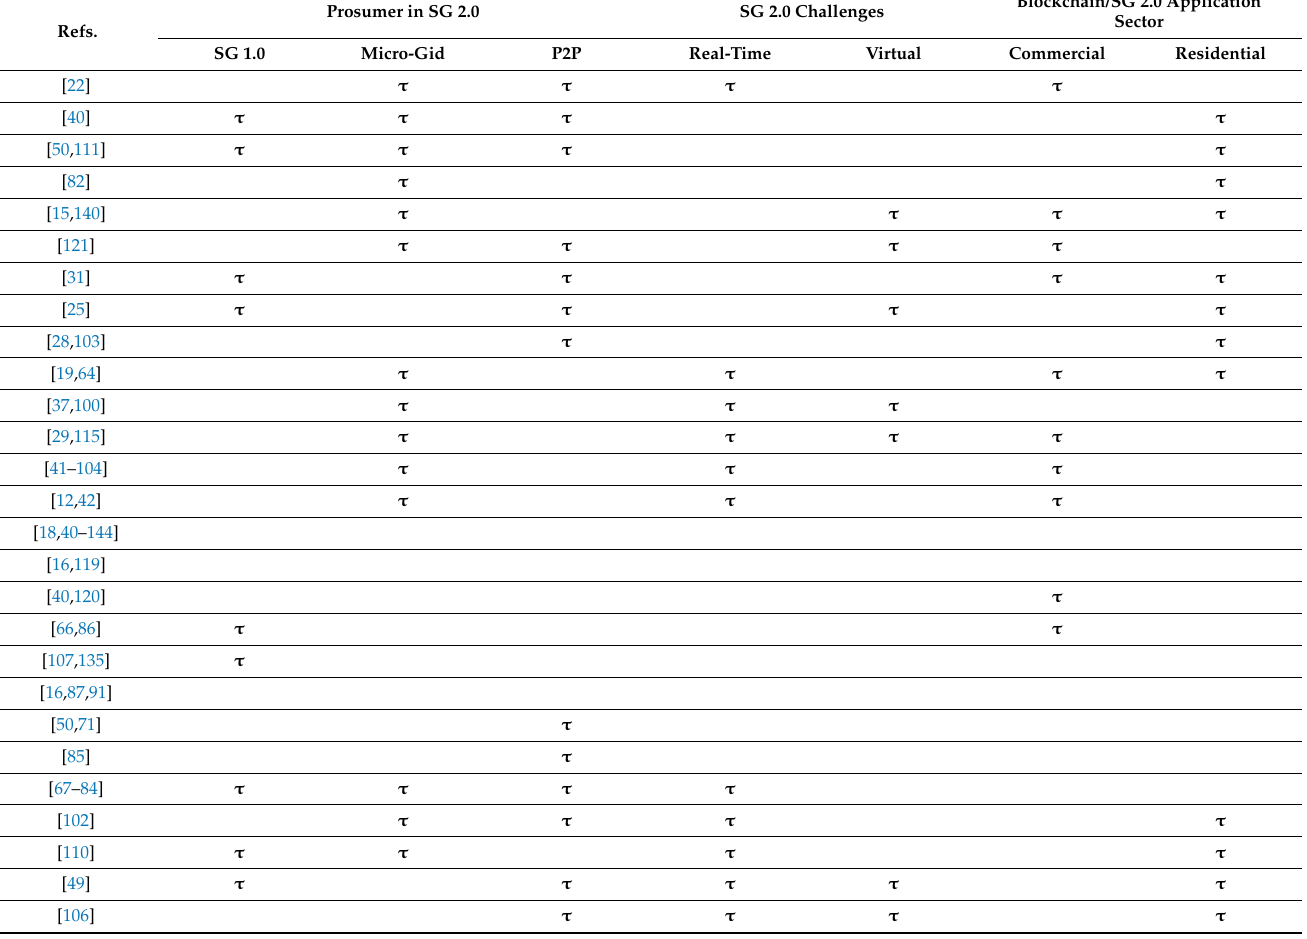
Table 5. Reported research on SG